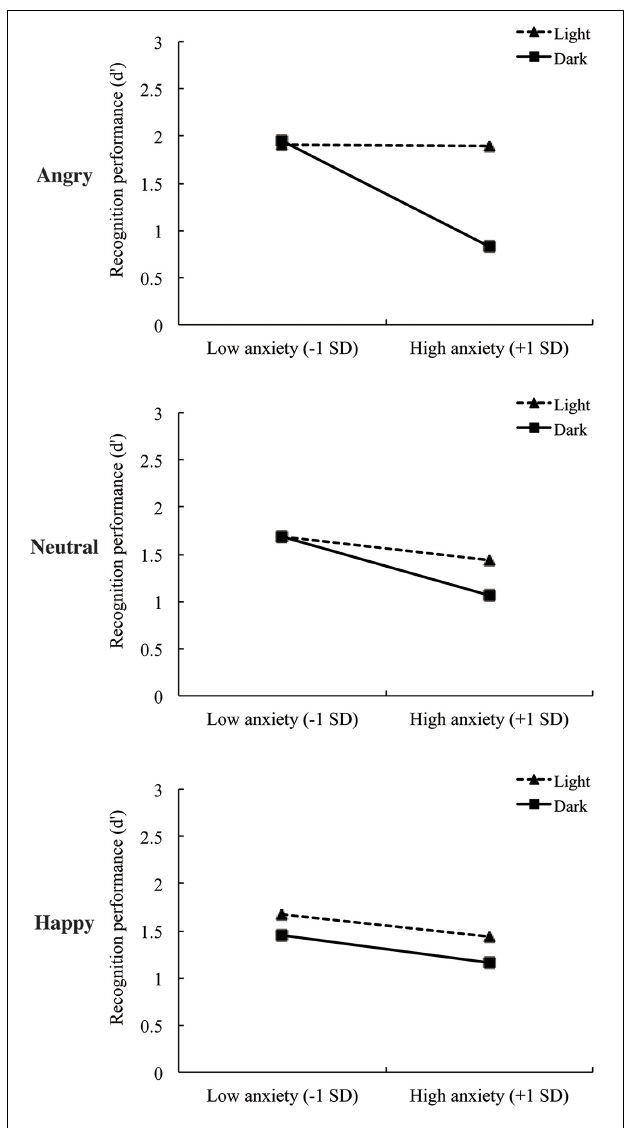
FIGURE 2 | Regression lines of recognition performance (d (cid:2) ) for each facial expression as a function of the darkness and state anxiety. The slopes illustrated in this graph were calculated with assigning the value of ± 1 SD of state anxiety to regression equation in accordance with Cohen and Cohen